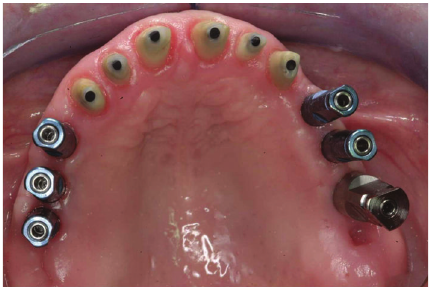
Figure 33: Final preparations from teeth 13 to 23 and positioning of the impression copings for a pick-up impression.